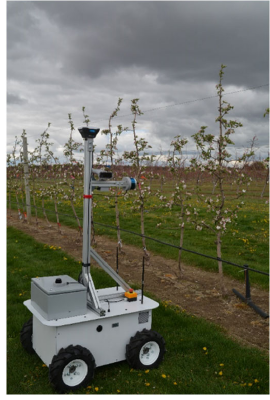
Figure 4. Mobile robot platform that was used for the data collection.